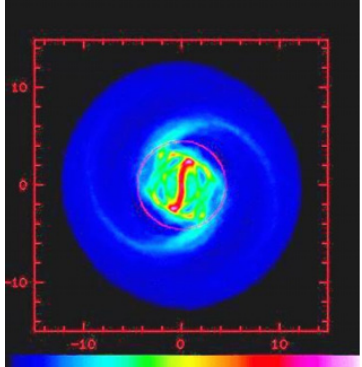
Figure 1. A stellar model that combines ordered and chaotic flows. The circle represents corotation. The bar inside corotation is built by particles in regular orbits, while the spirals beyond corotation are “chaotic” (axes in kpc). the spirals was less than (cid:4) / 2. The velocity dispersion in the initial conditions of the response